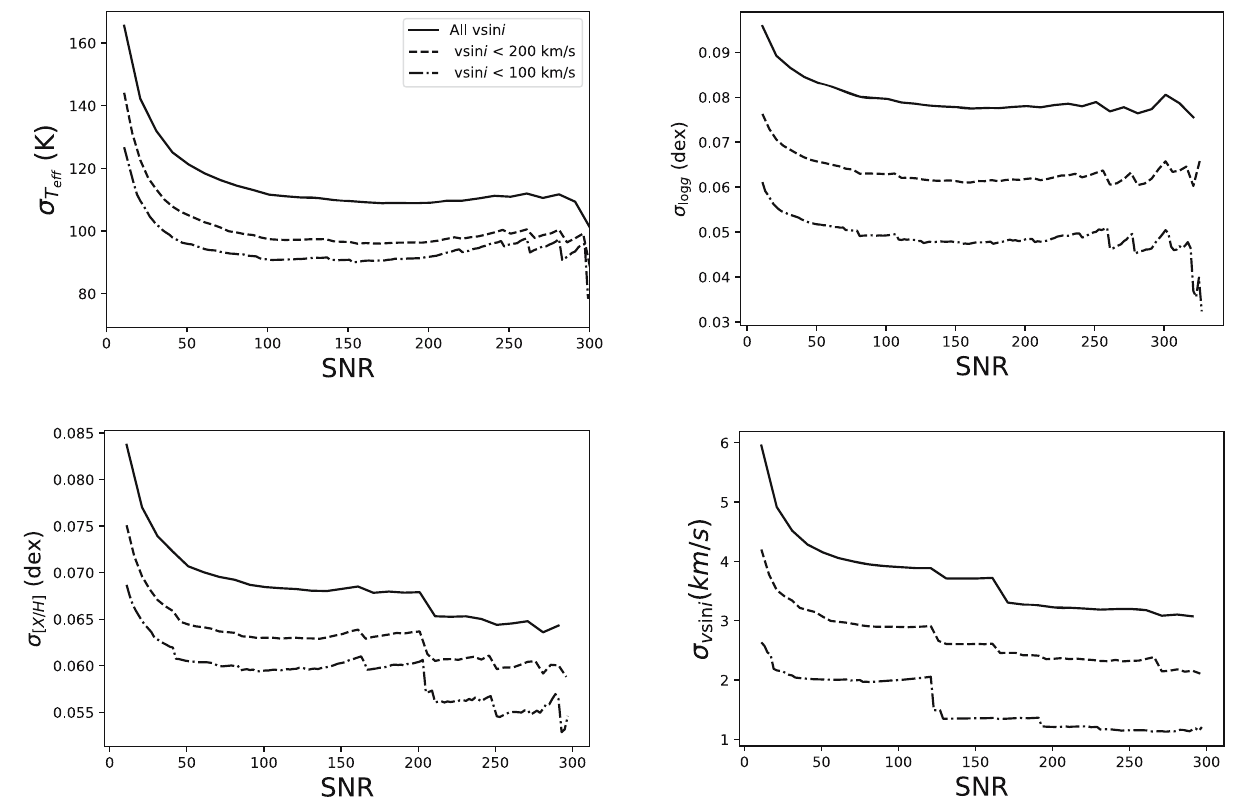
Figure 11: Average error bars for the observation predicted stellar parameters as a function of the SNR and for di ff erent ranges of stellar rotation.